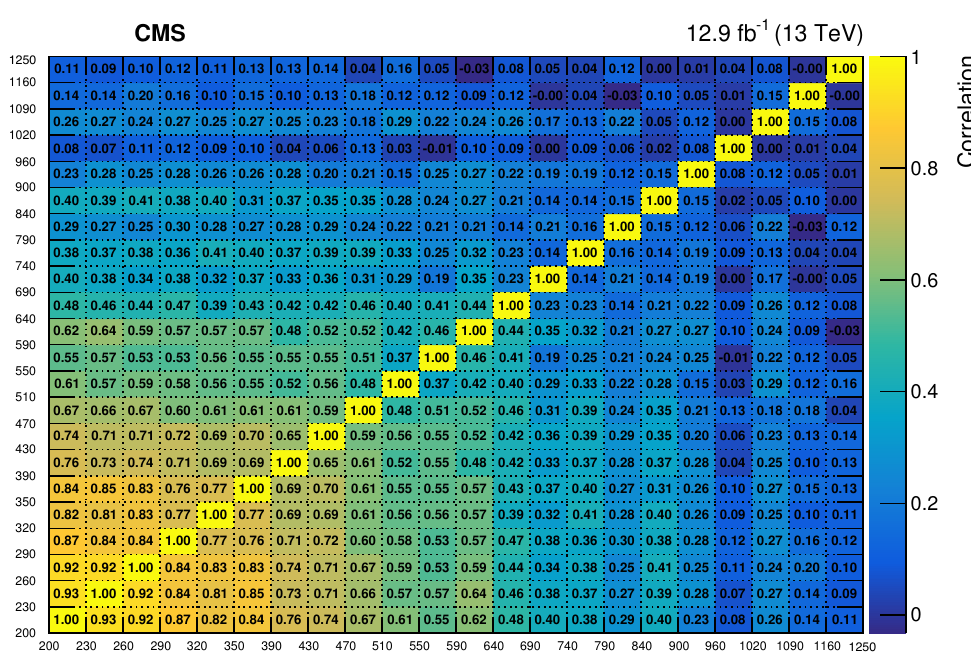
bins, expressed in GeV, are T { 23